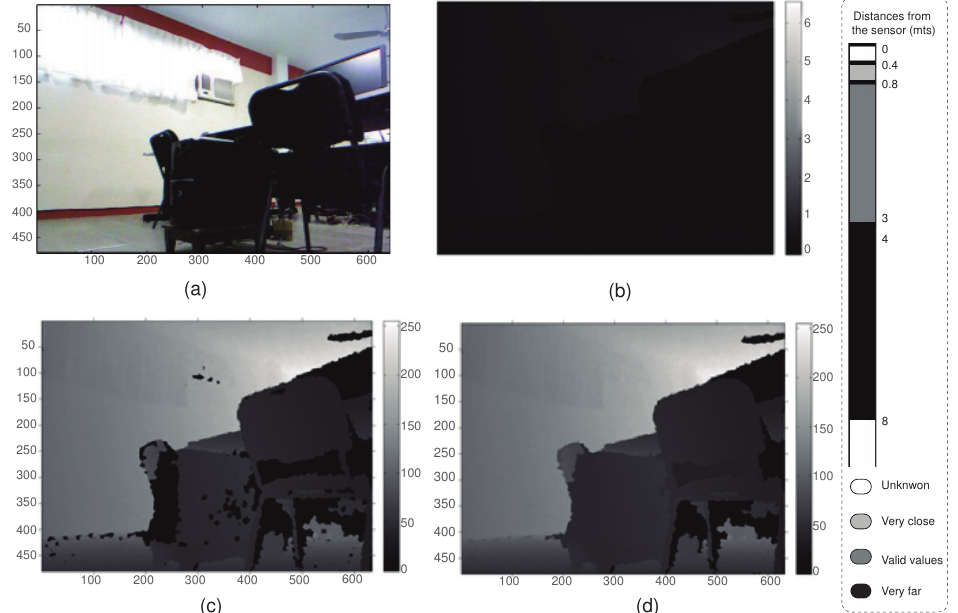
Figure 5. ( a ) RGB image; ( b ) original 16-bit depth image; ( c ) 8-bit normalized depth image (pixelwise bit reduction); and ( d ) 8-bit reconstructed depth image (morphological reconstruction). Module 3: Average depth. In this context, the robot can go to different places, and the system takes into account the work volume of the robot. Thus, the depth image processed by the previous module is divided into Left Subimage, Center Subimage, and Right Subimage (see Figure 6a–c) [28]. Each sub-image has a size of 211 × 400 pixels, representing the possible reference paths where the mobile platform can go: turn right, forward, and turn left. This division is computed by two factors: (1) the dimensions of the mobile robot (length = 400 millimeters, width = 410 millimeters, and height = 150 + 630 millimeters, where 150 millimeters are due to the physical robot and 630 millimeters are due to the Kinect sensor and its support) and (2) the sensed effective distance by the Kinect sensor (about 3000 millimeters).